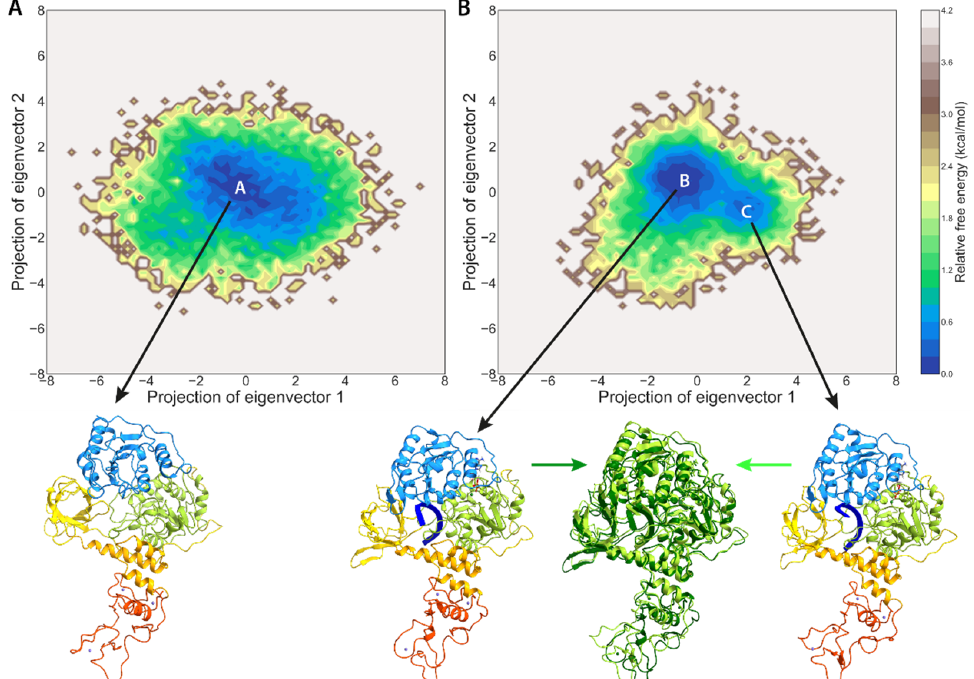
Figure 5. Free energy surface obtained from the 10- μ s-long MD trajectories projected on the first two principal components of the C α position’s covariance matrix for RNA-free ( A ) and RNA-engaged ( B ) NSP13. The surfaces are colored according to the relative free energy. Representative structures from the more populated regions are reported in the bottom panels for the single highly populated region of RNA-free NSP13 (Basin A, left panel) and RNA-engaged NSP13 (panels on the right). Of the three right-hand panels, the leftmost one and the rightmost one represent a structure from Basins B and C, respectively. In the central panel, the superimposition between the two latter structures is reported. When only one structure is reported, the ribbons are colored as in Figure 1C; in the superimposition, the structures from Basins B and C are in dark and light green, respectively. The Zn(II) and Mg(II) ions are shown as spheres, while the ADP molecules are shown as in sticks colored according to the atom type.